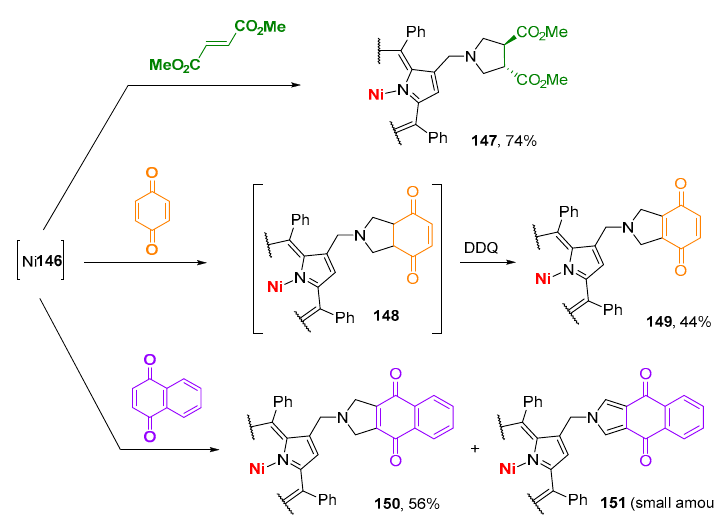
Scheme 39. Reaction of the azomethine ylide 146a with aromatic macrocycles